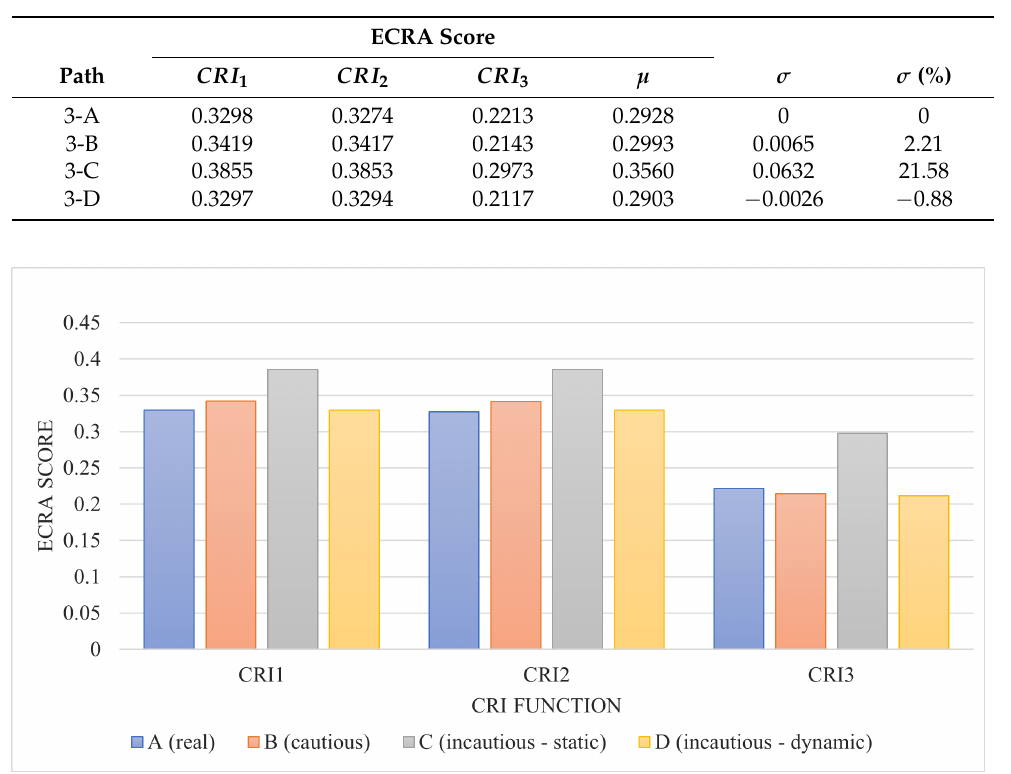
Figure 17. A plot showing resulting ECRA scores for four scenarios of test case 3, using three different CRI